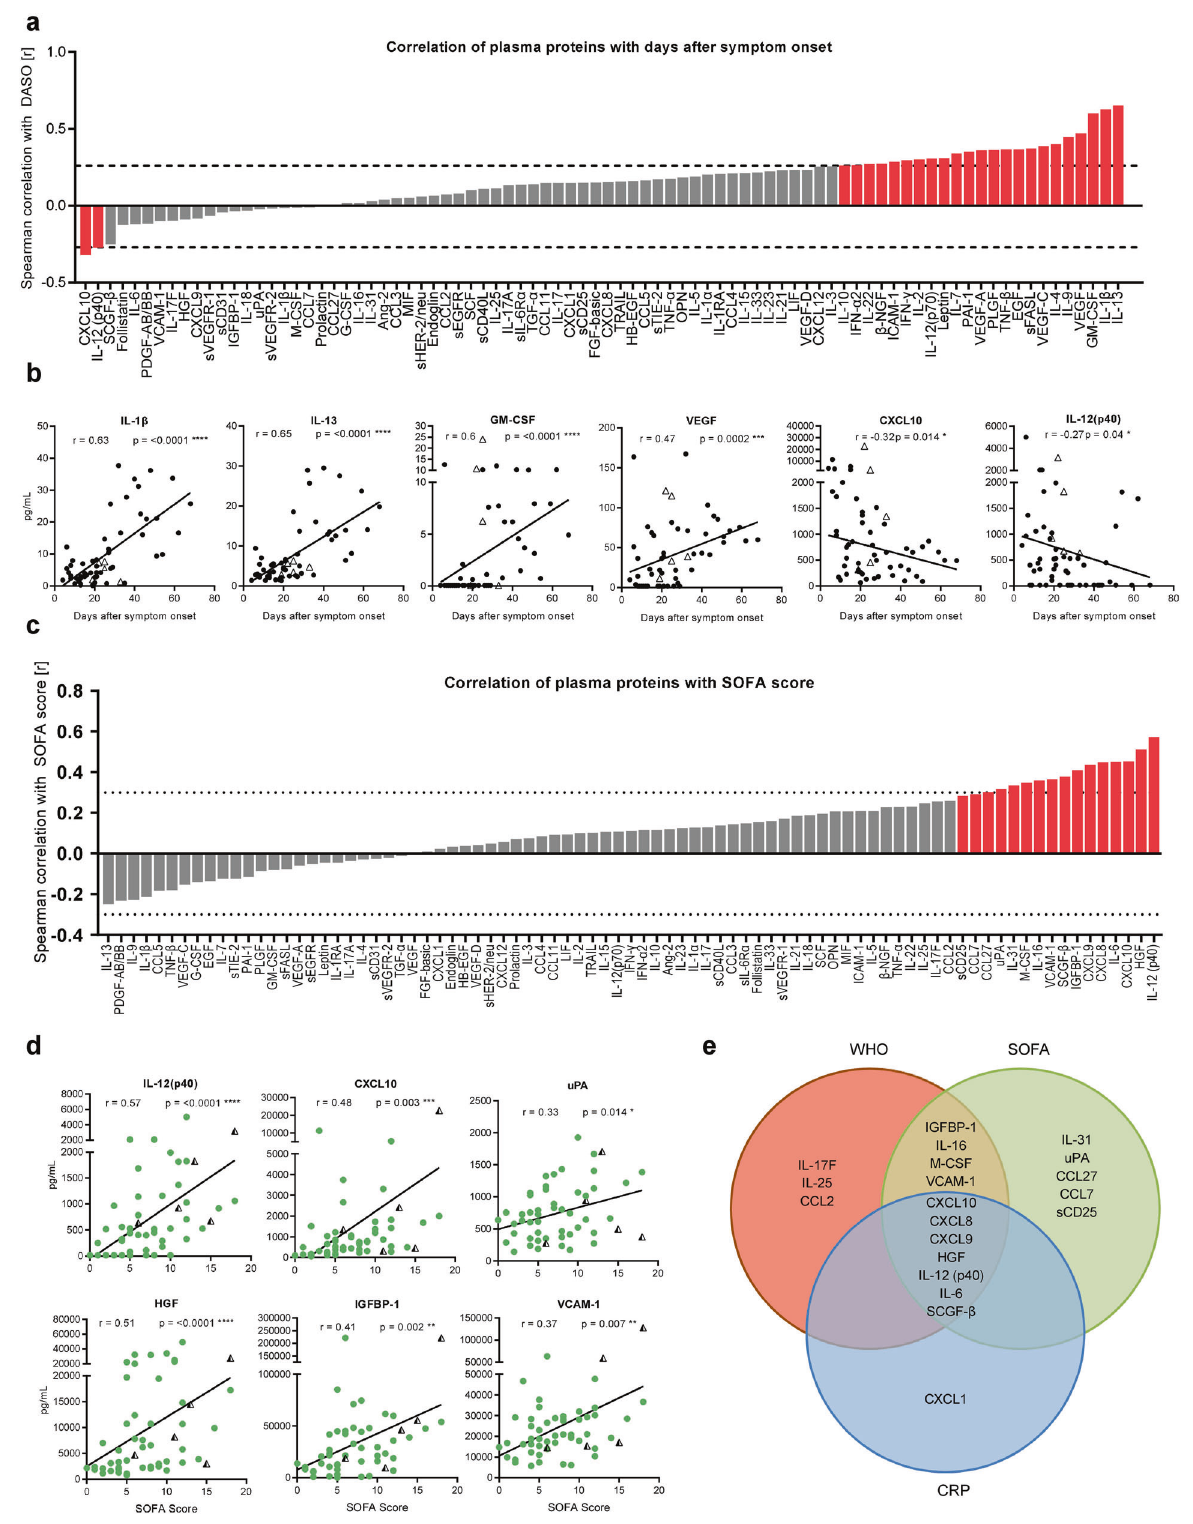
Fig. 6 Core plasma protein signature of severe COVID-19 consists of 11 in fl ammatory mediators and endothelial factors. Cytokine concentrations in patient sera were measured by Luminex-based multiplex assay. a , c Waterfall-plot representing correlation coef fi cient ( r ) of Spearman-correlation analysis between cytokines and disease duration as DASO ( a ) or SOFA score ( c ) from ICUs ( n = 58). Red columns represent signi fi cant results. Dotted lines represent the minimal Spearman-correlation coef fi cient ( r ) required for signi fi cant correlation. b Spearman-correlation analysis between representative cytokines and DASO. d Spearman correlation analysis of representative cytokines with SOFA score. e Venn diagram displaying signi fi cantly positive correlations between plasma proteins and CRP levels, SOFA-, and WHO score. Triangles represent the last samples from deceased patients. Statistical analysis: Spearman correlation. * P < 0.05, ** P < 0.01, *** P < 0.001, **** P < 0.0001 Signal Transduction and Targeted Therapy (2021)